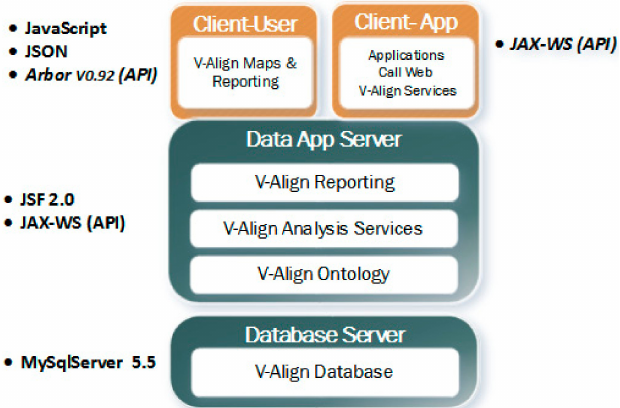
Figure 3. V-Align Software Tool Implementation Architecture and